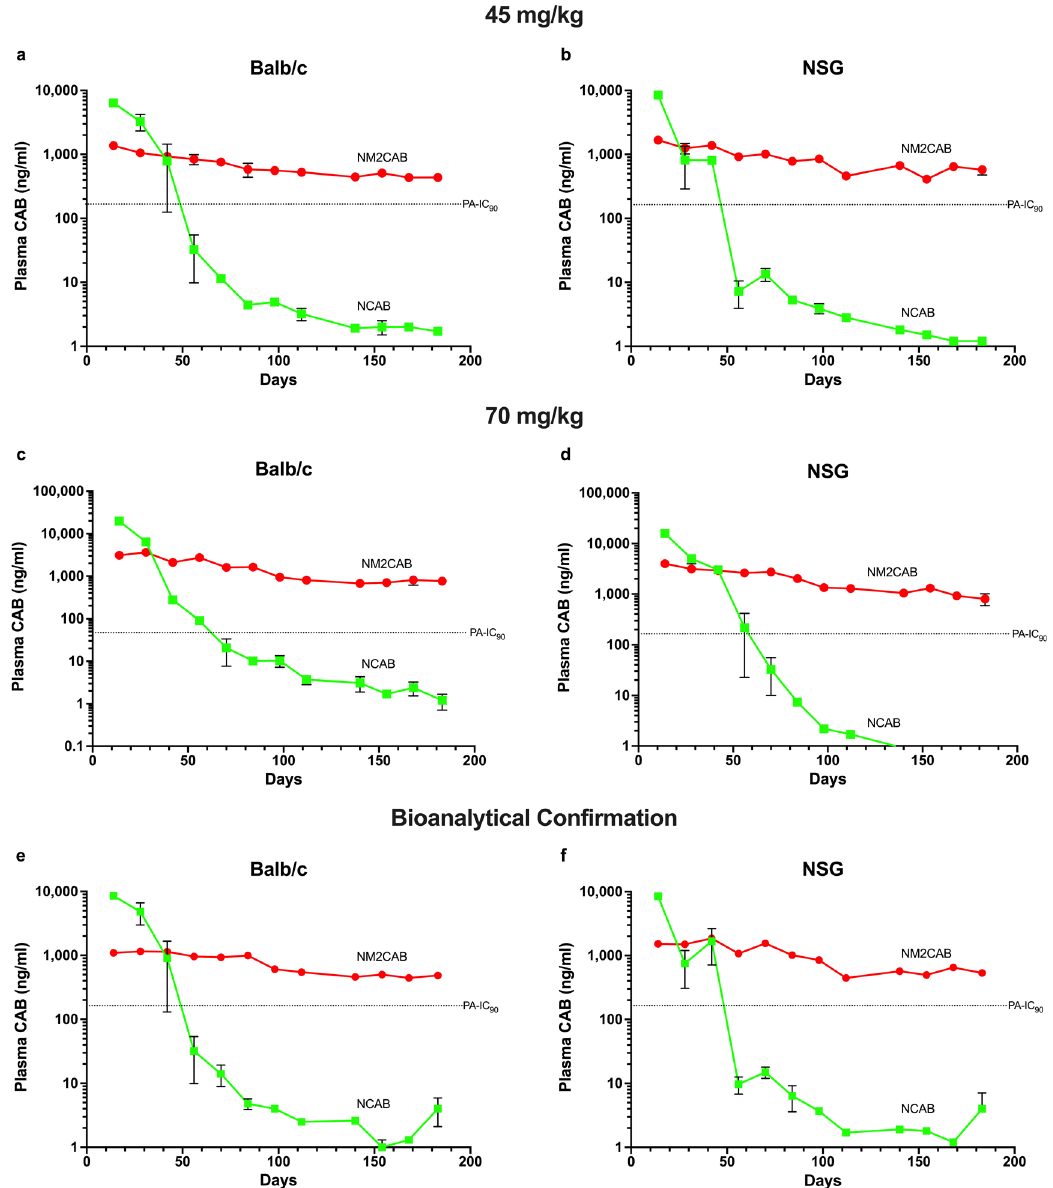
Fig. 2 CAB drug plasma concentrations in Balb/c and NSG mice. Male Balb/c or female NSG mice were given a single intramuscular injection of 45 or 70 mg CAB equivalents/kg of NCAB or NM2CAB. Plasma was collected every other week for 6 months at which time the study was terminated. CAB concentrations were quantitated by LC-MS/MS by Covance laboratories ( a – d ); treatment with 45 mg/kg in male Balb/c ( a ) and female NSG mice ( b ); treatment with 70 mg/kg in male Balb/c ( c ) and female NSG mice ( d ). CAB concentrations in plasma samples were also quantitated at UNMC (bioanalytical con fi rmation). Plasma CAB concentrations for the 45 mg/kg treatment groups are shown for male Balb/c ( e ) and female NSG mice ( f ). The dotted line indicates the CAB protein-adjusted IC 90 (PA-IC 90 ). Data are expressed as mean ± SEM ( N varied from 2 to 6 animals per group per time point due to loss of animals by natural causes, in both NCAB and NM2CAB treatment groups, or inadequate plasma volume collected during the study period, with exact values for each time point provided in the source data [10.6084/m9. fi